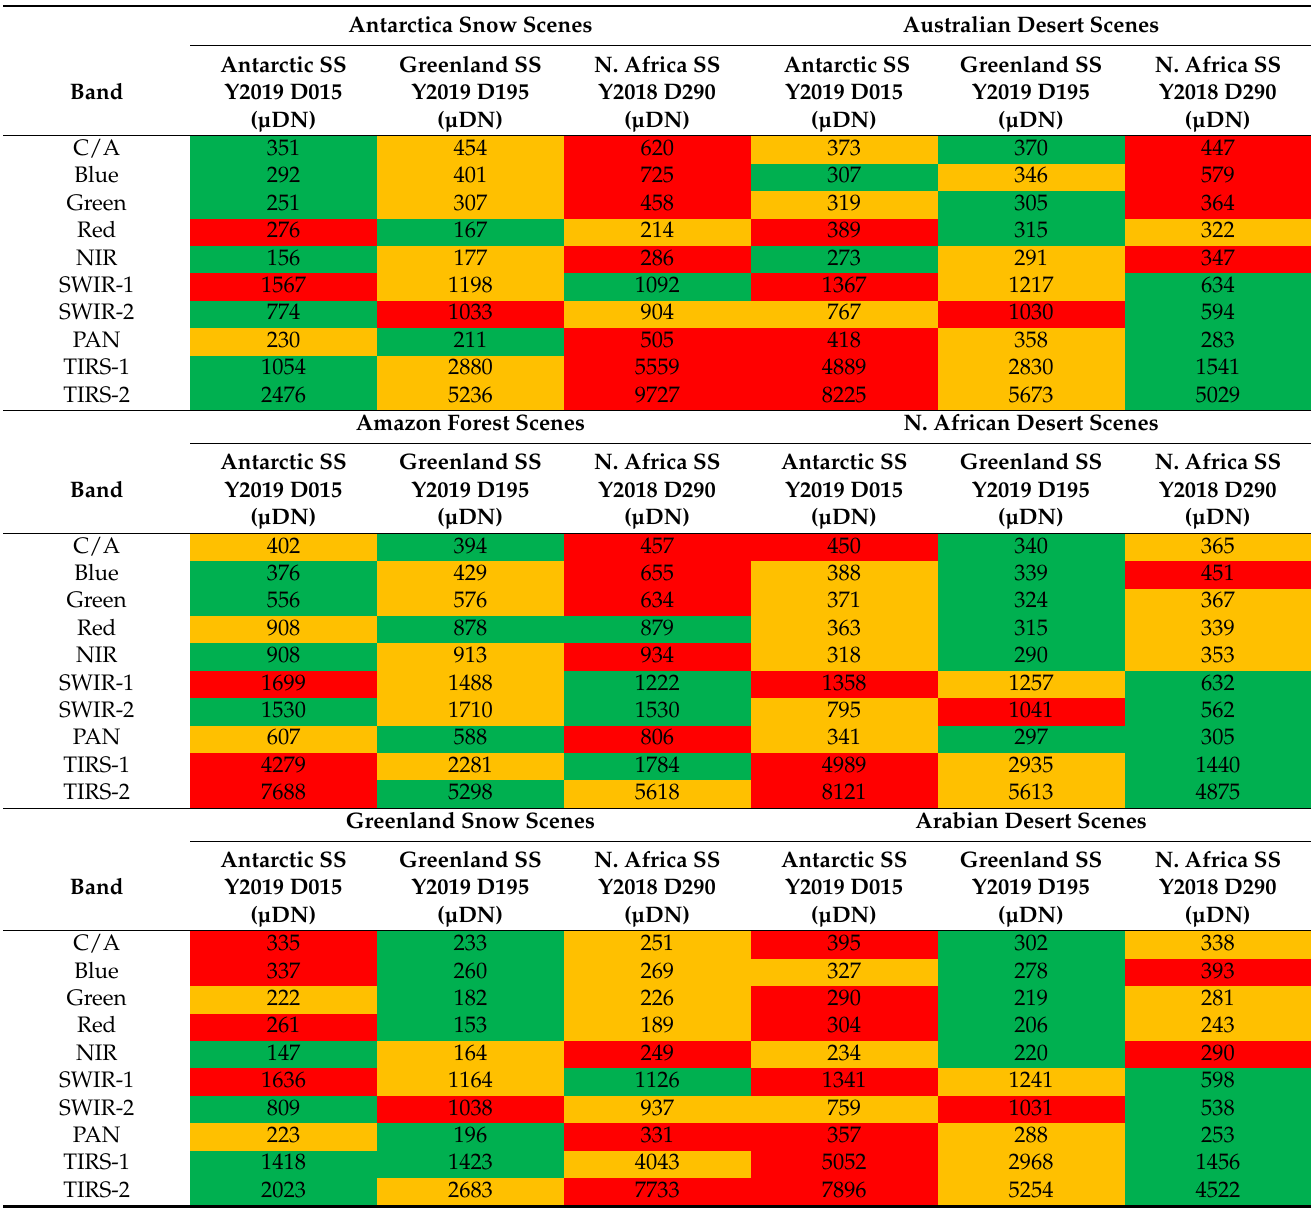
Table A1. Full table of Streaking Metric comparisons; red data is statistically the worst, followed by yellow data, and green data is statistically the best; if multiple cells are the same color that data is statistically the same, as proven by the t